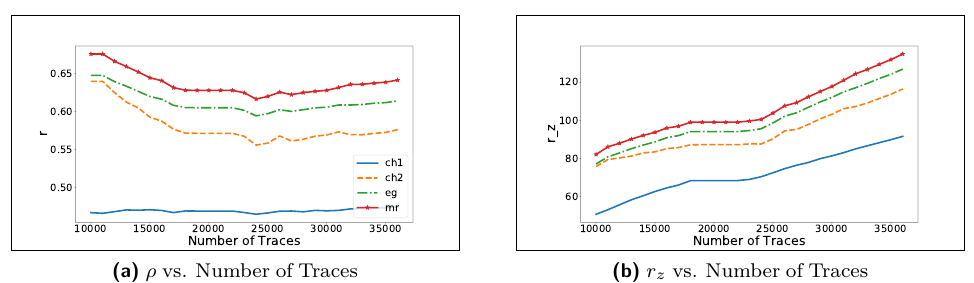
Figure 9: Comparison among spatial diversity and single channels. Maximal ratio and equal gain show a net advantage in terms of correlation over channel 1 and channel 2 for any number of